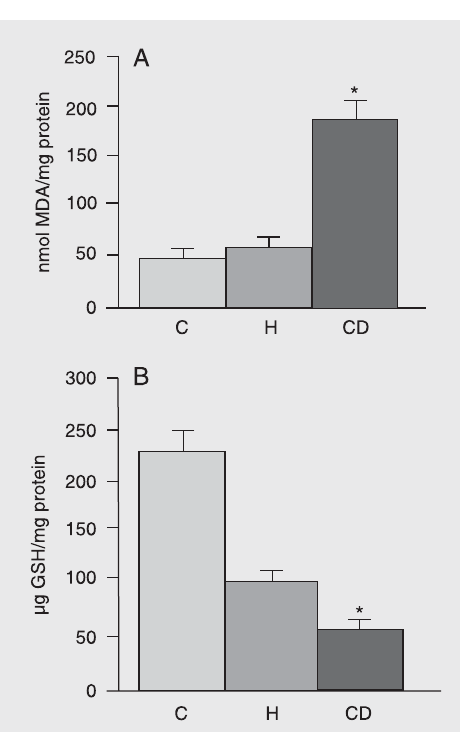
Data are reported as means ± SEM ng atoms of O 2 min -1 mg protein -1 . RCR = respiratory control rate; S3 (state 3) = oxygen consumption in the presence of ADP; S4 (state 4) = oxygen consumption in the absence of ADP; CD = choline-deficient diet; H = high-fat diet; C = standard diet (control).